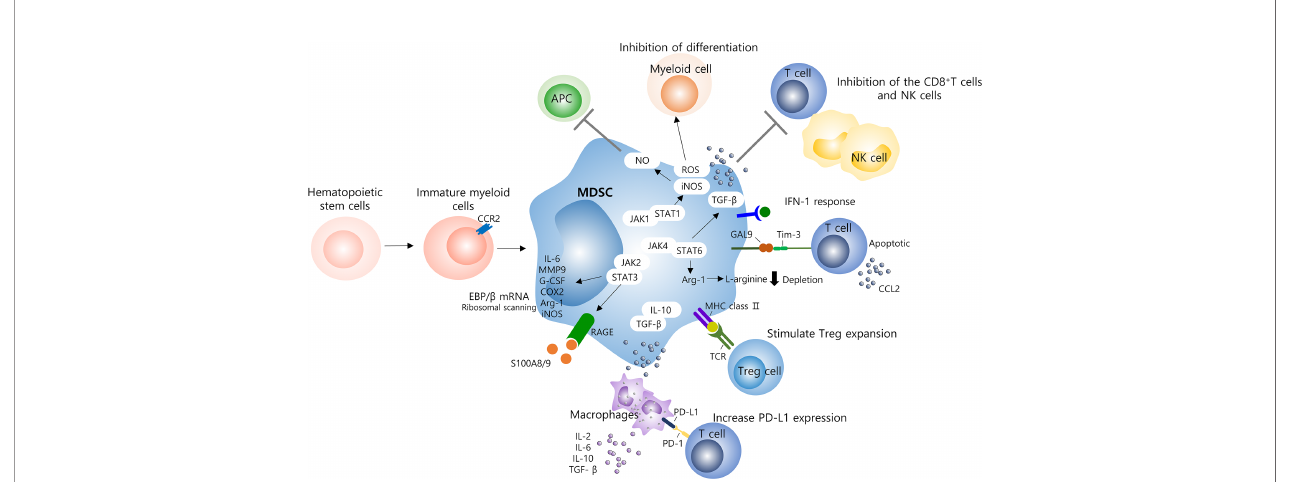
FIGURE 1 | Molecular mechanisms of MDSCs on the immune system. Several mechanisms contribute to MDSC-induced immune suppression and hyperin fl ammatory activation in viral infection and including those with COVID-19 patients. Specially, MDSCs are able to suppress T cells, NK cells, and other myeloid cells function. T cells are mainly inhibited through the production of ROS or depletion of L-arginine, and the delayed production of IFN-1 seems to result in the continuous accumulation of MDSCs into the lungs. Several signaling pathways, such as STAT1/3/6, are involved, to increase levels of immunosuppressive factors such as ROS, iNOS, NO, and Arg-1, which inhibit T cell responses. High levels of PD-L1 found in MDSCs and macrophages can reduce the activation of antigen-speci fi c T cells by binding to the PD-1 receptor on T cells. In addition, the release of IL-10 and TGF- b by MDSC induces additional in fl ammatory system of macrophages by recruiting lymphocytes and granulocytes as well as in fl ammatory monocytes. MDSCs, myeloid derived suppressor cells; NK, natural killer cell; ROS, reactive oxygen species; TGF- b , transforming growth factor- b ; APC, antigen presenting cells; NO, nitric oxide; STAT, signal transducer and activator of transcription; JAK, janus activated kinase; IL, interleukin; MMP, matrix metalloporteinases; G-CSF, granulocyte colony stimulating factor; COX-2, cyclooxygenase 2; Arg,